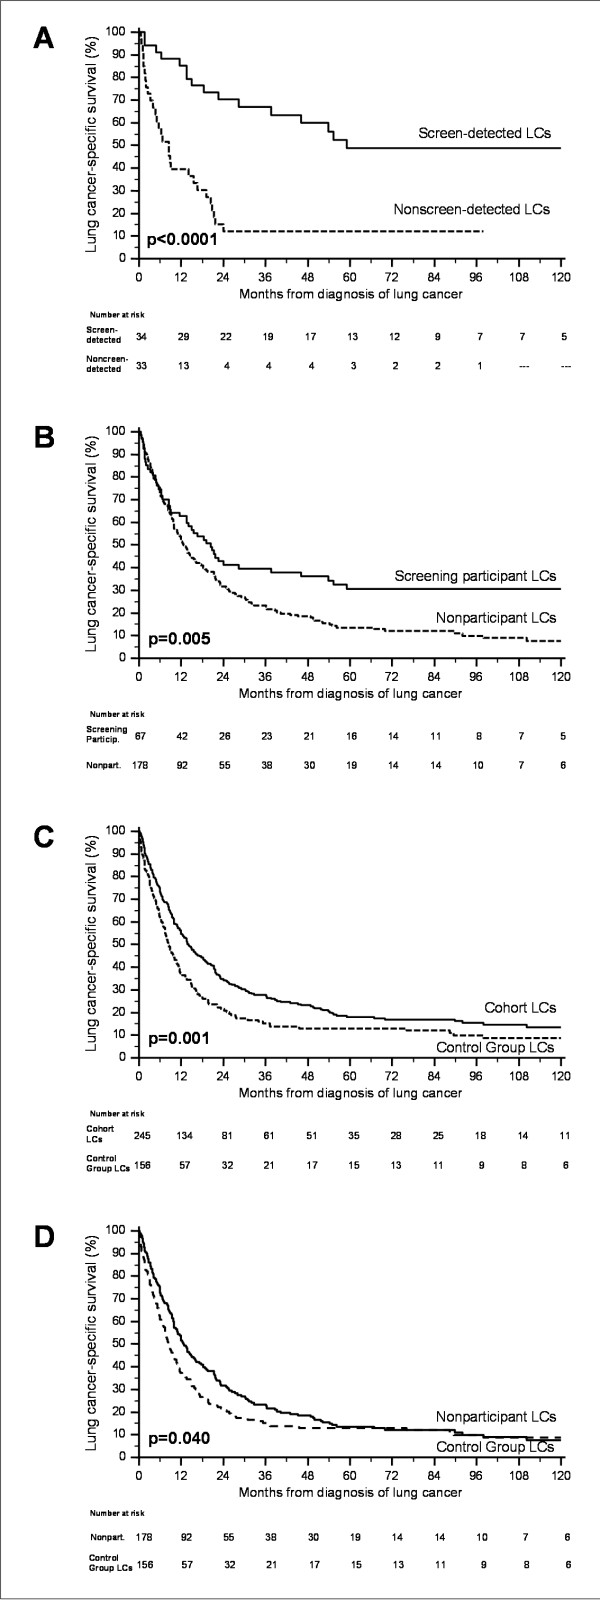
Comparison of lung cancer (LC) -specific survival curves (Kaplan-Meier). Shown are (A) screen-detected LCs (n = 34) vs. nonscreen-detected LCs (n = 33), (B) screening participant LCs (n = 67) vs. nonparticipant LCs (n = 178), (C) cohort LCs (n = 245) vs. control group LCs (n = 156), and (D) nonparticipant LCs (n = 178) vs. control group LCs (n = 156).